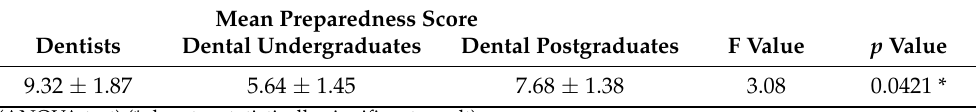
Table 4. Preparedness scores of dentists, dental undergraduates, and postgraduates.